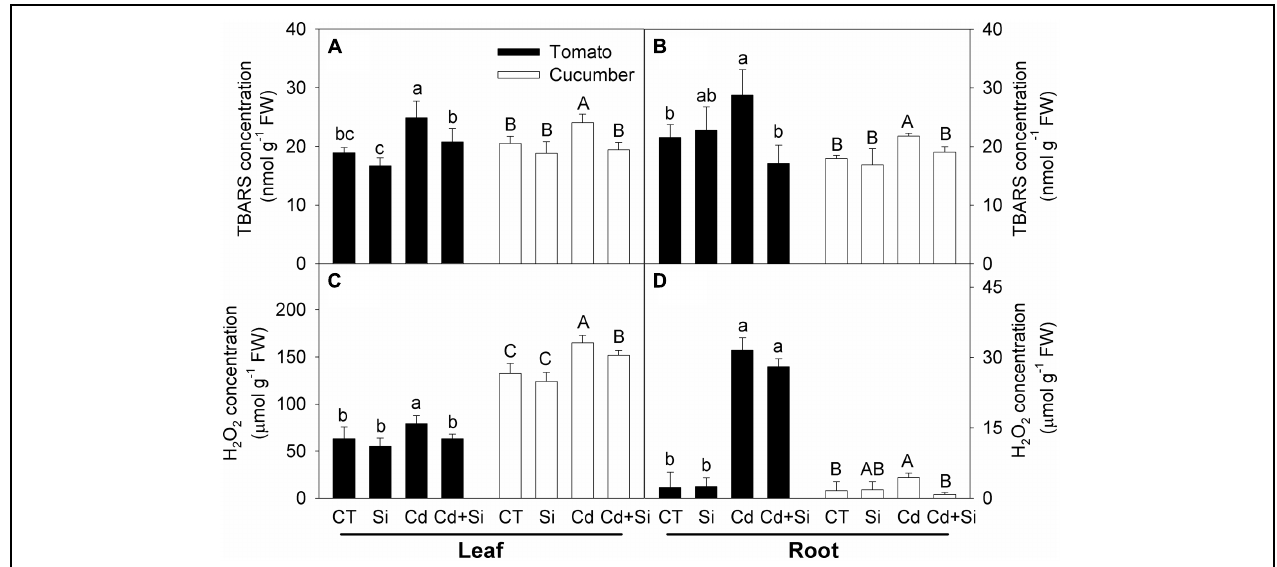
FIGURE 4 | Effects of Si on TBARS and H 2 O 2 contents in leaves (A,C) and roots (B,D) in tomato and cucumber under Cd stress. Bars with different letters means significant difference at P < 0.05 according to one-way ANOVA (Lower-case and upper-case letters indicate significance for tomato and cucumber, respectively). TBARS, thiobarbituric acid reactive